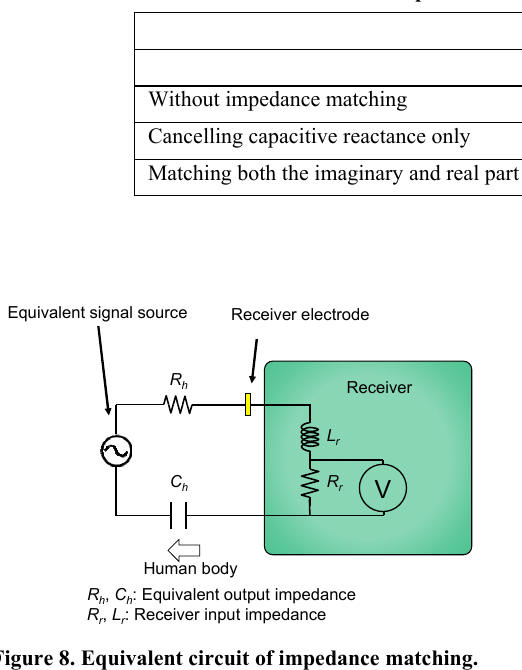
Table 1. Relationship between received power and impedance